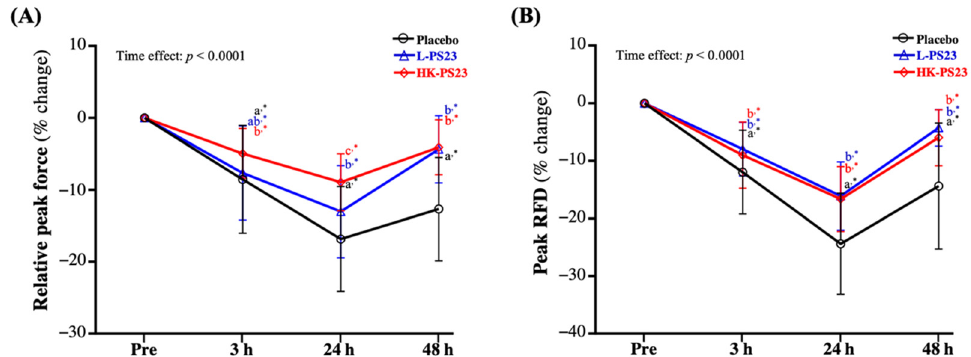
Figure 3. Effects of 6 weeks of L-PS23 and HK-PS23 supplementation on percentage change in IMTP test ( A ) relative peak force and ( B ) peak RFD. Data are expressed as mean ± SD for n = 35 subjects per group. Different superscript letters (a, b, c) indicate significant difference between groups at the same time point ( p < 0.05). * indicates that each group is significantly different from pre-EIMD at different time points ( p < 0.05). RFD, rate of force development.